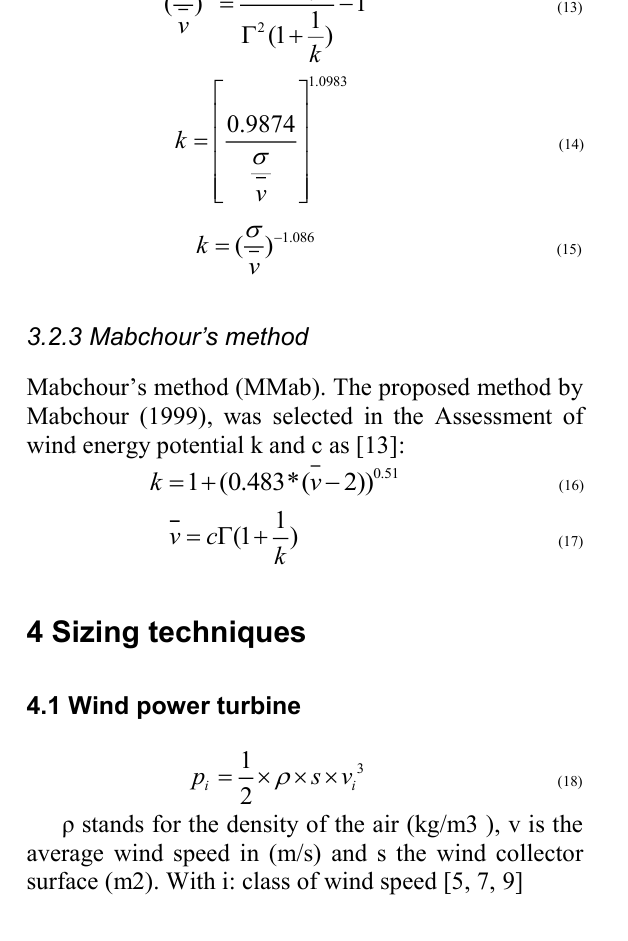
Table 2. Plot of the least squares line of Laayoune site and calculations by the Excel sheet.